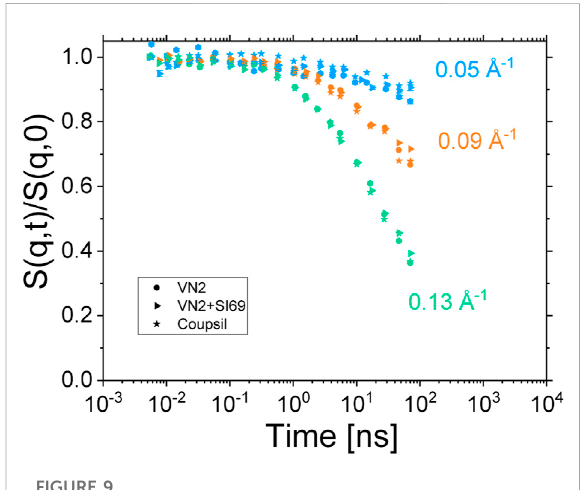
FIGURE 9 ISFs measured at 413 K for samples made of 40 phr Coupsil (stars),VN2(circles)andVN2+SI69(triangles)particles.Coloursare for the different scattering vectors indicated on the